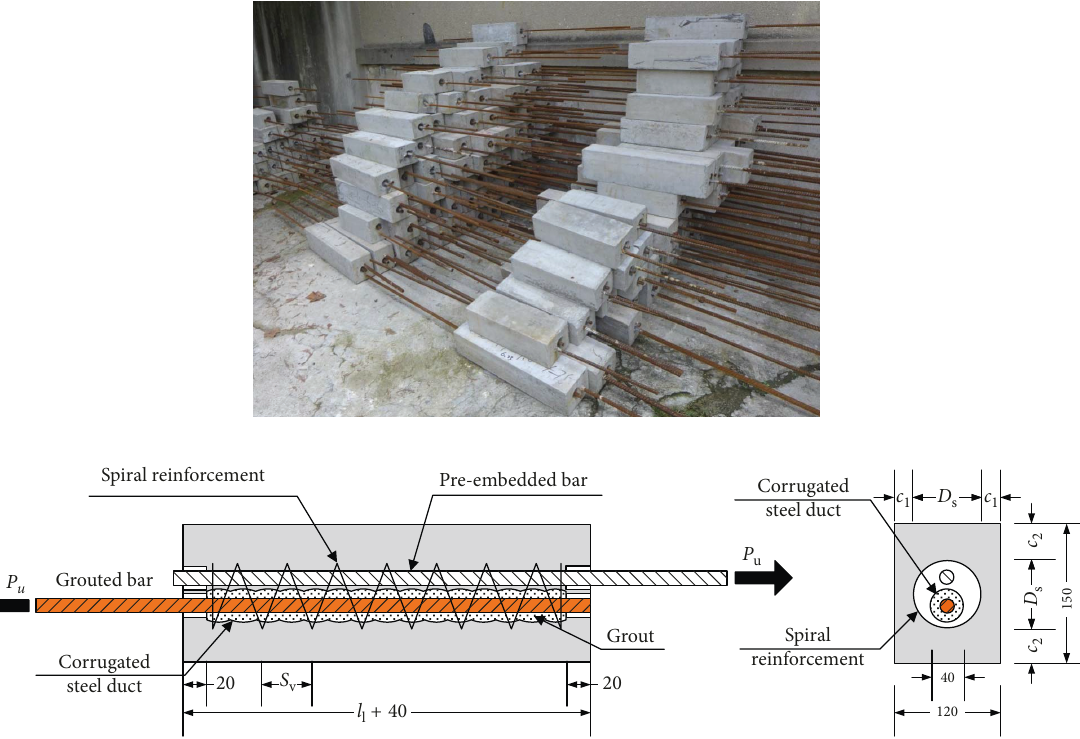
Figure 2: Configuration of splice specimen (unit: mm).